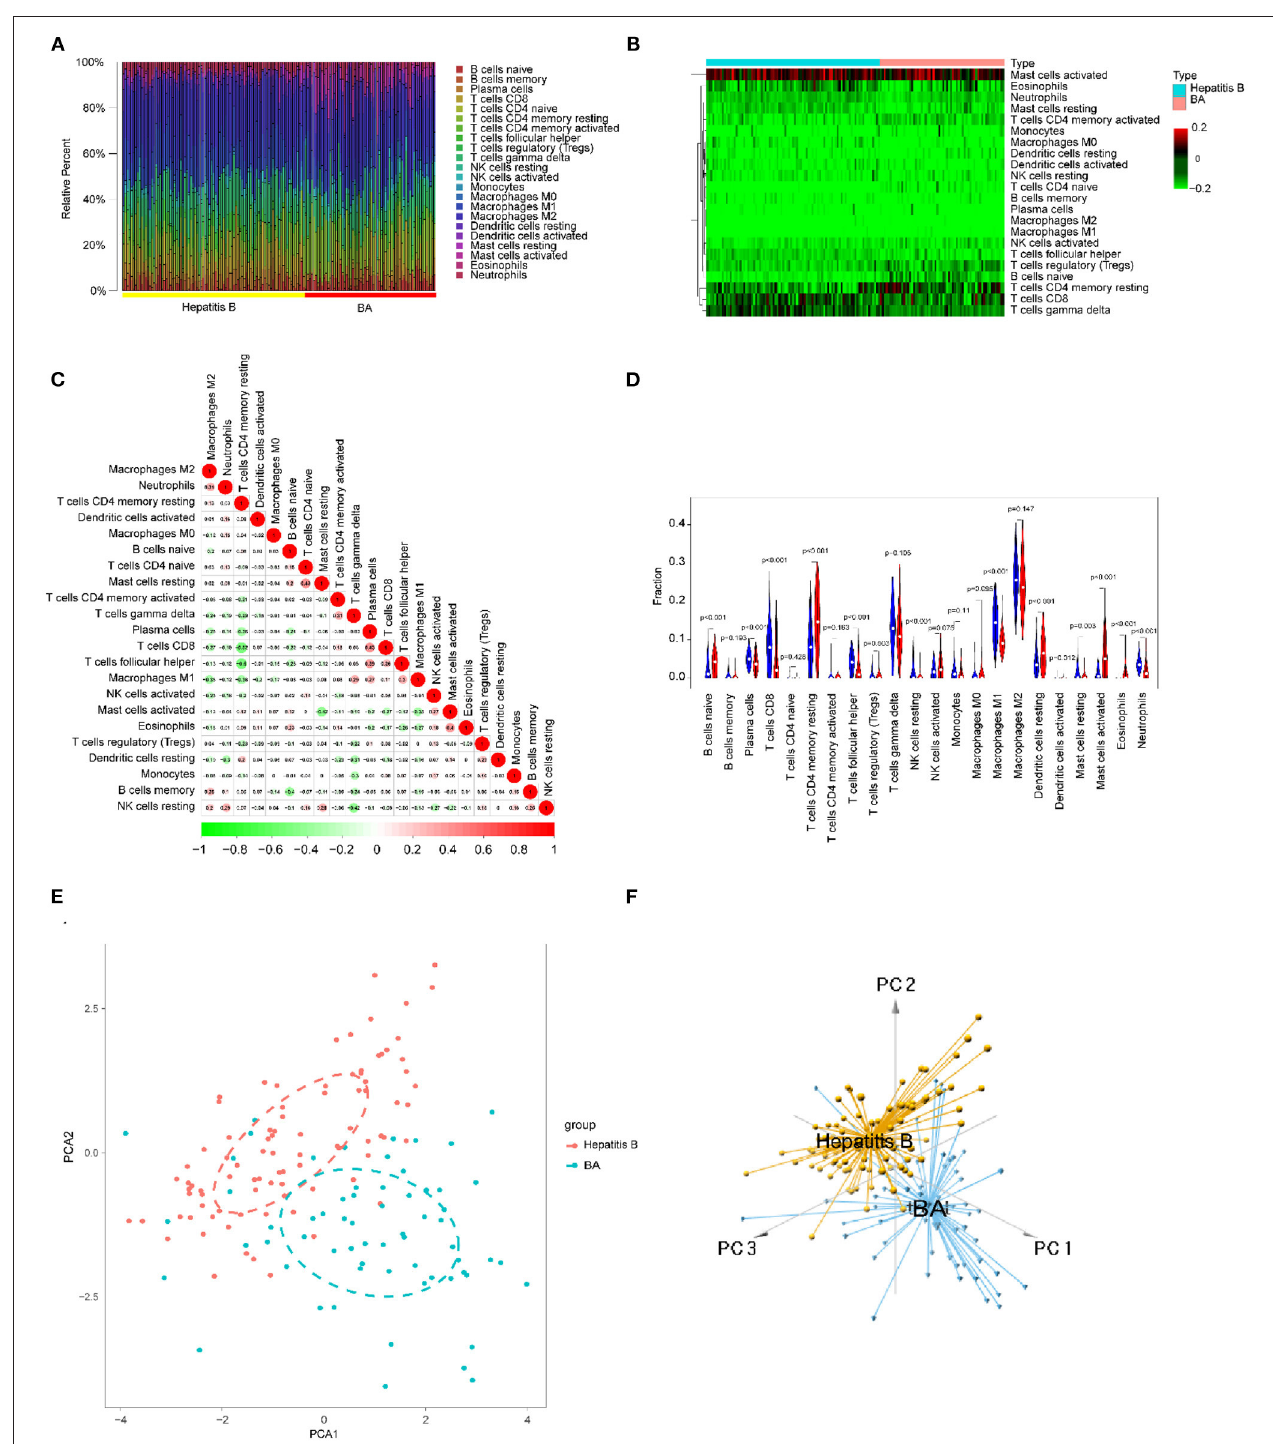
FIGURE 12 | Immune cells infiltrating in BA and viral hepatitis B. (A) The barplot reflects the relative content of 22 immune cells in each sample. (B) Heatmap of the 22 immune cell proportions. (C) Correlation heatmap of 22 immune cells. The size of the colored circles represents the strength of the correlation; red represents a positive correlation and green represents a negative correlation. (D) Violin diagram of the proportion of 22 types of immune cells among the different groups. (E,F) PCA cluster plot of immune cell infiltration between BA and viral hepatitis B samples.